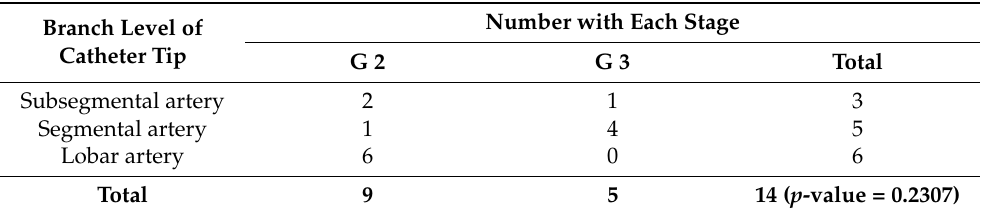
Figure 2. Cone-beam computed tomography showing occlusion of the right branch of hepatic artery (black arrow) after transarterial chemoembolization with drug-eluting microspheres preloaded with irinotecan. Table 5. Branch level of catheter tip with the incidence of adverse events, compared using Pearson’s Chi-squared (significance at p <